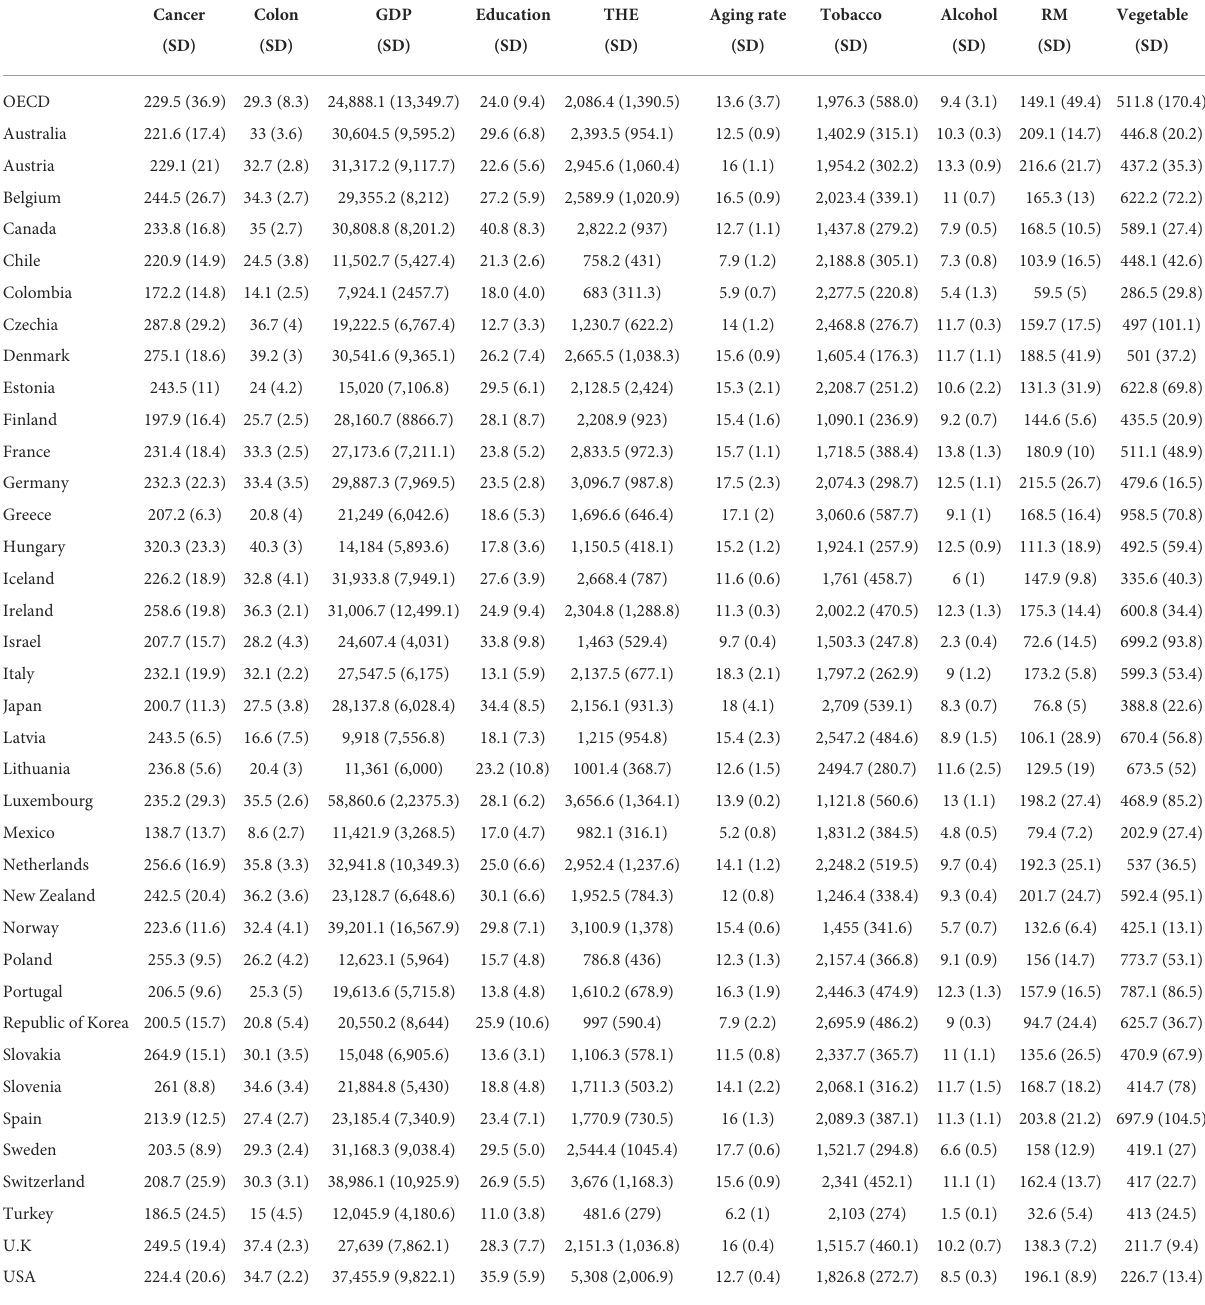
TABLE 1 Summary for dependent and explanatory variables of 37 OECD countries, average from 1989 to